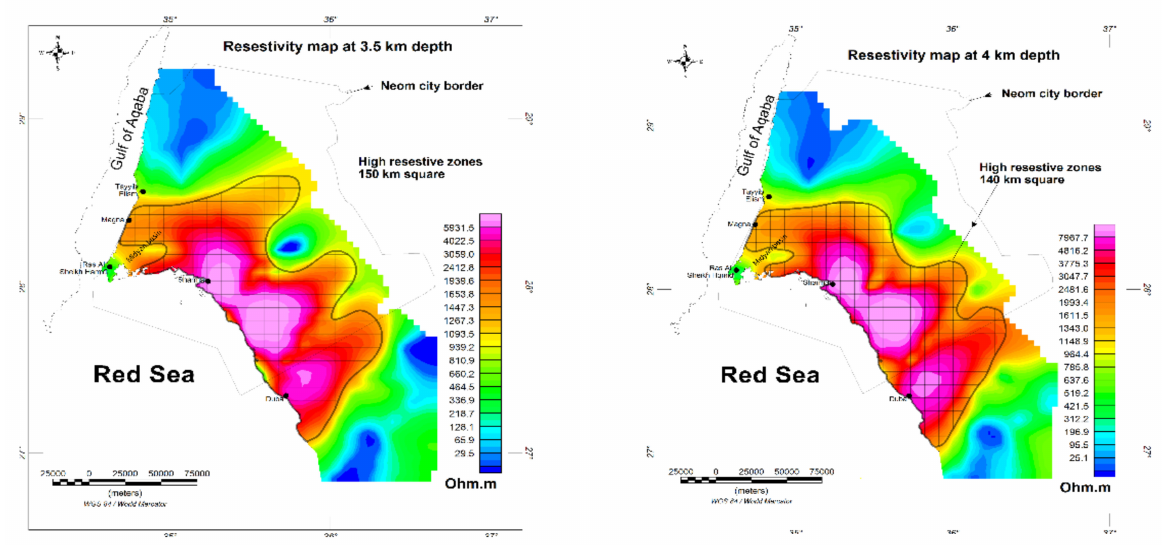
Figure 7. Extracted resistivity maps from AMT data inversion at various